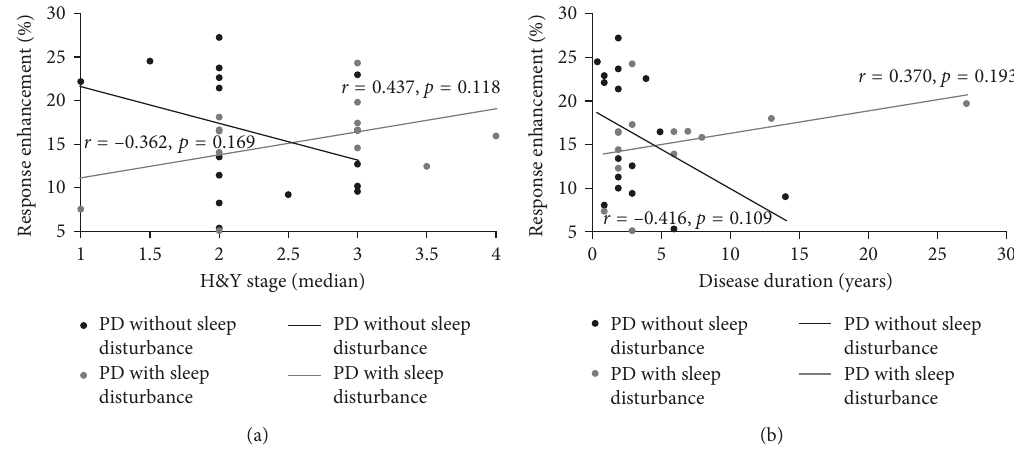
Figure 6: Correlation of H&Y stage and disease duration with response facilitation. (a) No significant relationship between H&Y stage and response facilitation. x -axis: H&Y stage; y -axis: response facilitation. (b) No significant relationship between disease duration and response facilitation. x -axis: disease duration; y -axis: response